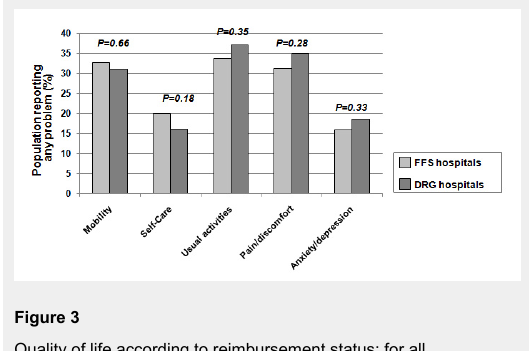
Quality of life according to reimbursement status; for all comparisons there was no statistical significant difference (p <0.05 for all chi-square